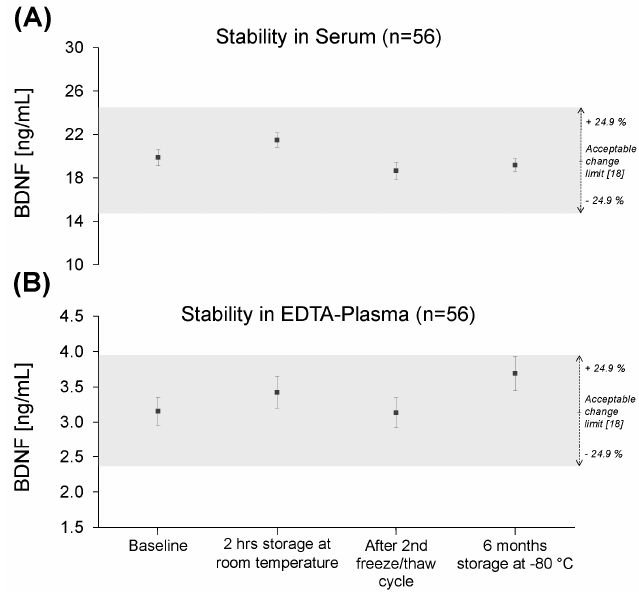
Figure 2. BDNF concentrations at “Baseline” (T1), “2 hrs storage at room temperature” (T2), “After 2nd freeze/thaw cycle” (T3), and “6 months storage at − 80 °C” (T5). ( A ) Serum samples, ( B ) EDTA-plasma samples. Grey box: 24.9% acceptable change limit as calculated with the inter-assay precision declared by the manufacturer of the BDNF ELISA kit [20]. All error bars are SEM. BDNF: brain-derived neurotrophic factor, EDTA: ethylenediaminetetraacetic acid, ELISA: enzyme-linked immunosorbent assay, hrs: hours, SEM: standard error of the mean.